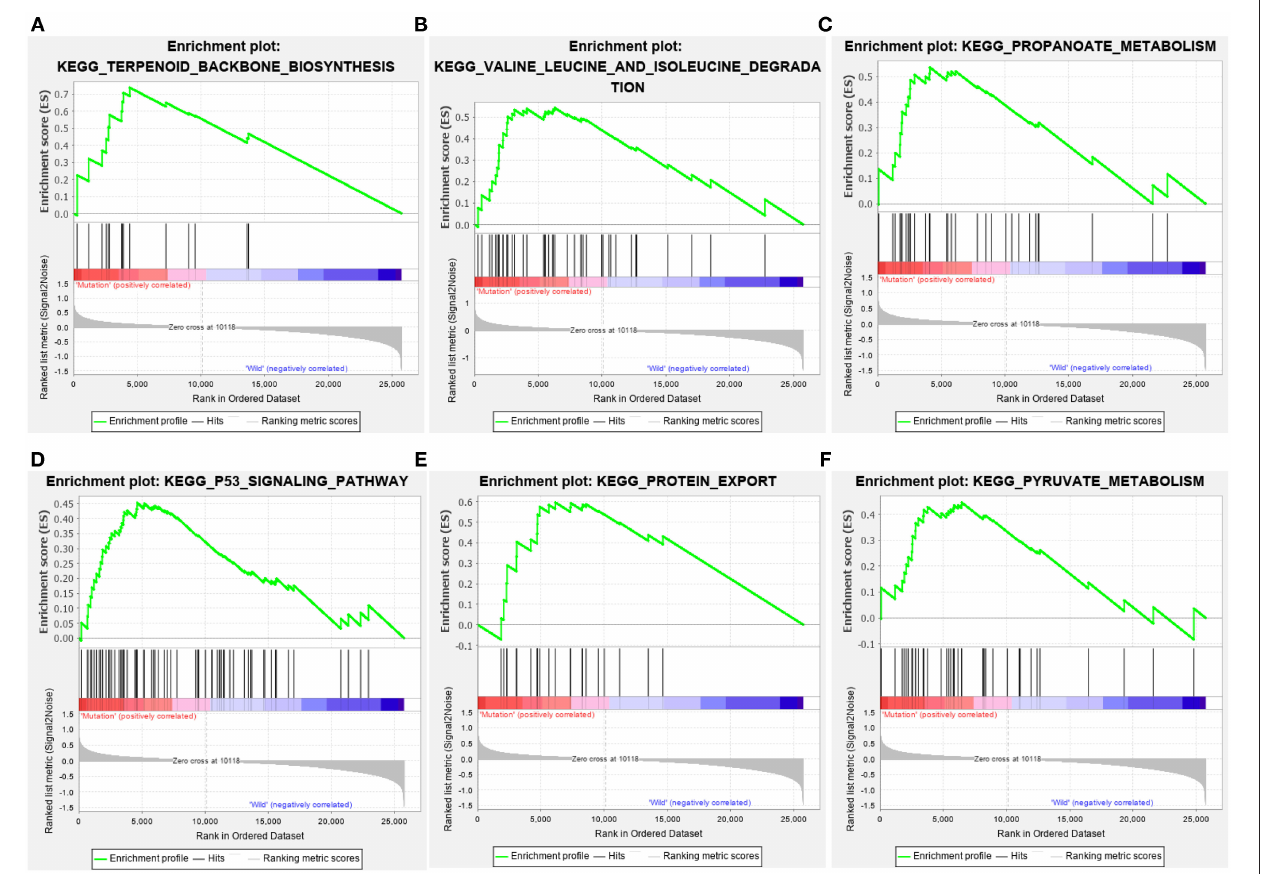
FIGURE 3 | The significantly enriched pathways in mutated ELP6 GC samples based on GSEA. (A) Terpenoid backbone biosynthesis pathway, (B) valine leucine and isoleucine degradation pathway, (C) propanoate metabolism pathway, (D) p53 signaling pathway, (E) protein export pathway, and (F) pyruvate metabolism pathway. GC, gastric cancer; GSEA, Gene Set Enrichment